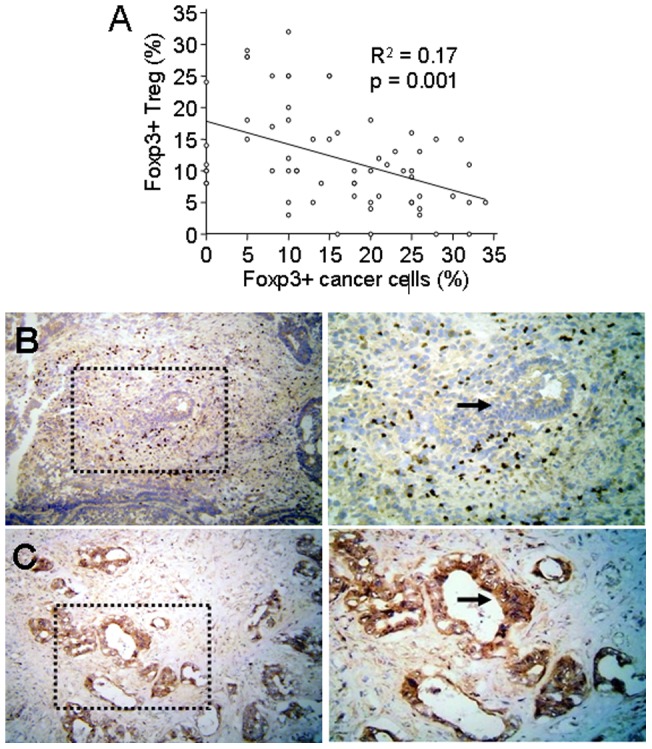
Correlation of Foxp3+ Treg with Foxp3+ cancer cell expression and immunohistochemical analysis of Foxp3+ Treg and Foxp3+ cancer cells.(A) Significant inverse correlation of Foxp3+ cancer cell expression with the Foxp3 Treg expression. Regression analysis; R2, coefficient of determination. (B) Increased numbers of Foxp3+ Treg in Foxp3 negative cancer tissue (arrow). (C) Only occasionally or no Foxp3+ Treg in Foxp3 positive cancer tissue (arrow). DAB brown color, Haemalaun blue color – nuclear counterstaining. Representative example demonstrates area of magnifications x100 (left) and x200 (right).